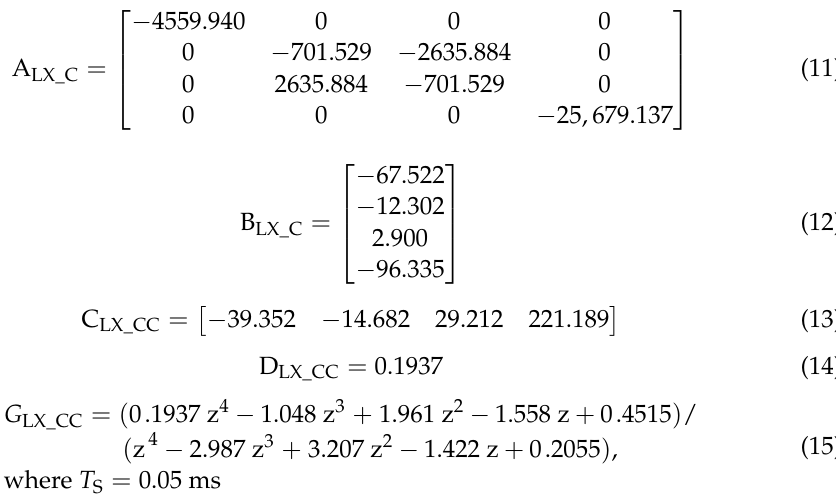
Figure 8. Bode plot of controller for LRAMB along the X-axis. Since the order of the dynamic model of controller for LRAMB along the X-axis is 4, the state space representation and its discrete-time transfer function are as: